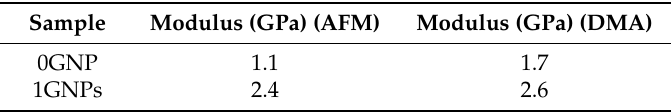
Table 2. Comparison between elastic modulus obtained by AFM tests and storage modulus obtained by DMA tests at 25 ◦